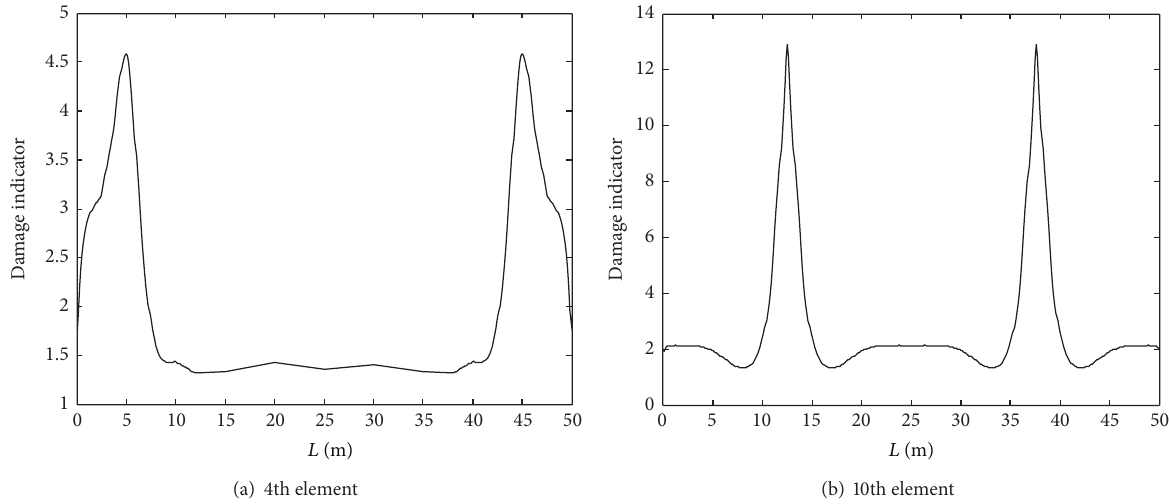
Figure 4: Damage indicator when damage is inflicted at (a) fourth element and (b) tenth